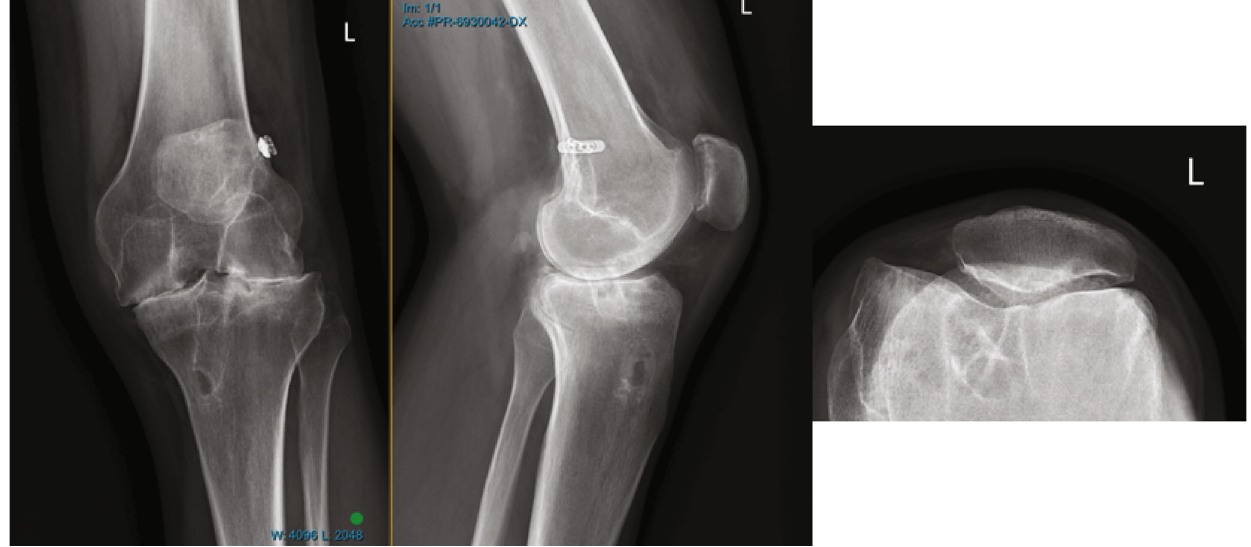
Figure 4: Radiograph of the left knee 7 months later in